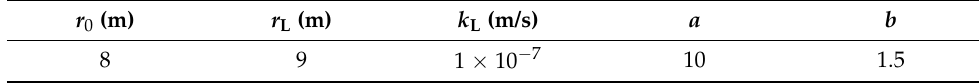
Table 5. Parameters of Qingdao Jiaozhou Bay Subsea Tunnel.